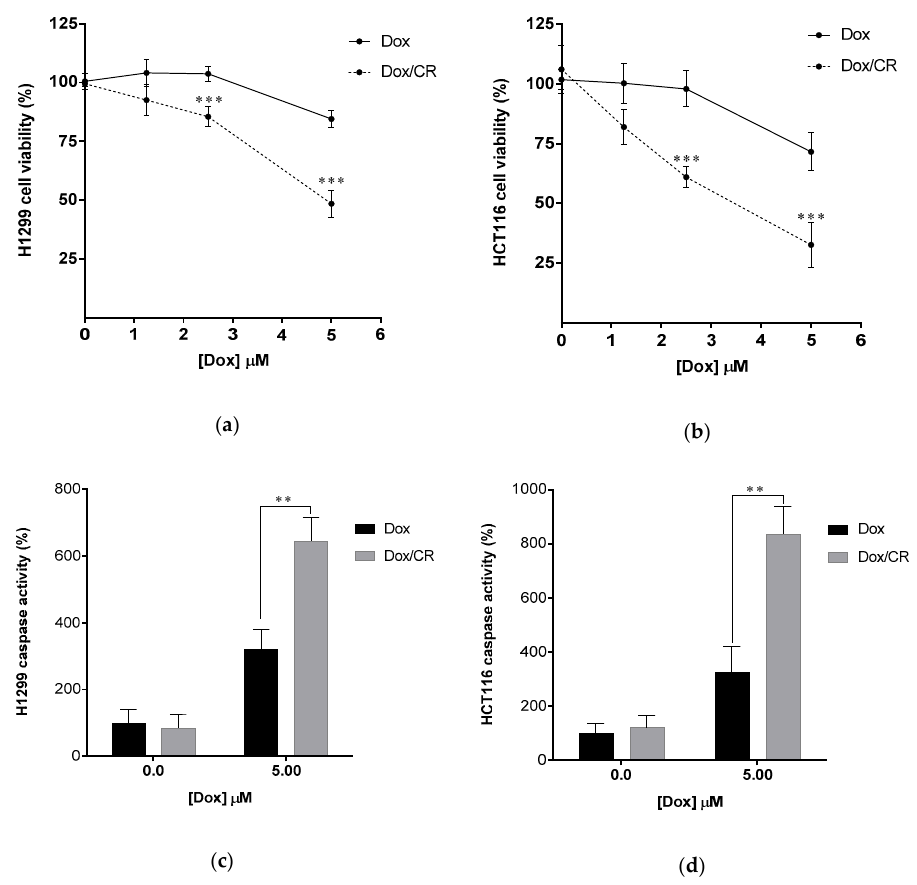
Figure 7. CR enhances Dox sensitivity of cancer cells. ( a , b ) Enhancement of Dox-induced